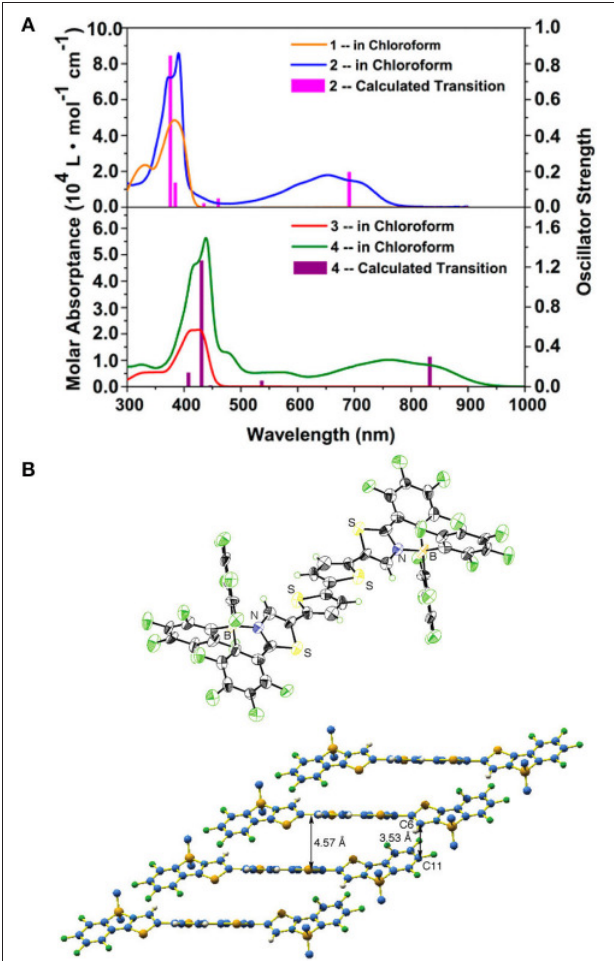
FIGURE 10 | Absorption spectra of 20 / 21 (upper) and 22 / 23 (bottom) in chloroform (A) and Single crystal structure of 8 (B) . Reprinted with permission from Job et al. (2010) and Zhu et al. (2016). Copyright (2010, 2016) American Chemical